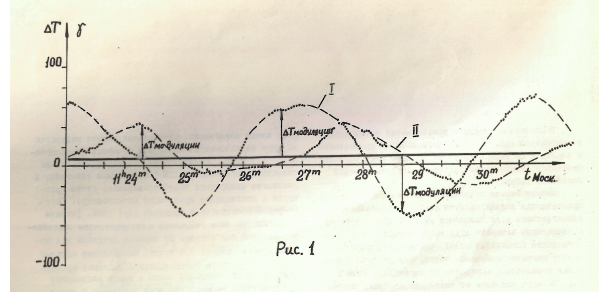
Figure 8. Interference in Kosmos-321 data as shown in the cata- log (Dolginov et al., 1976). Roman I and II stand for two sensors, actual measurements are indicated with dots, and dashed lines con- tinuously complement the measurements of each sensor.